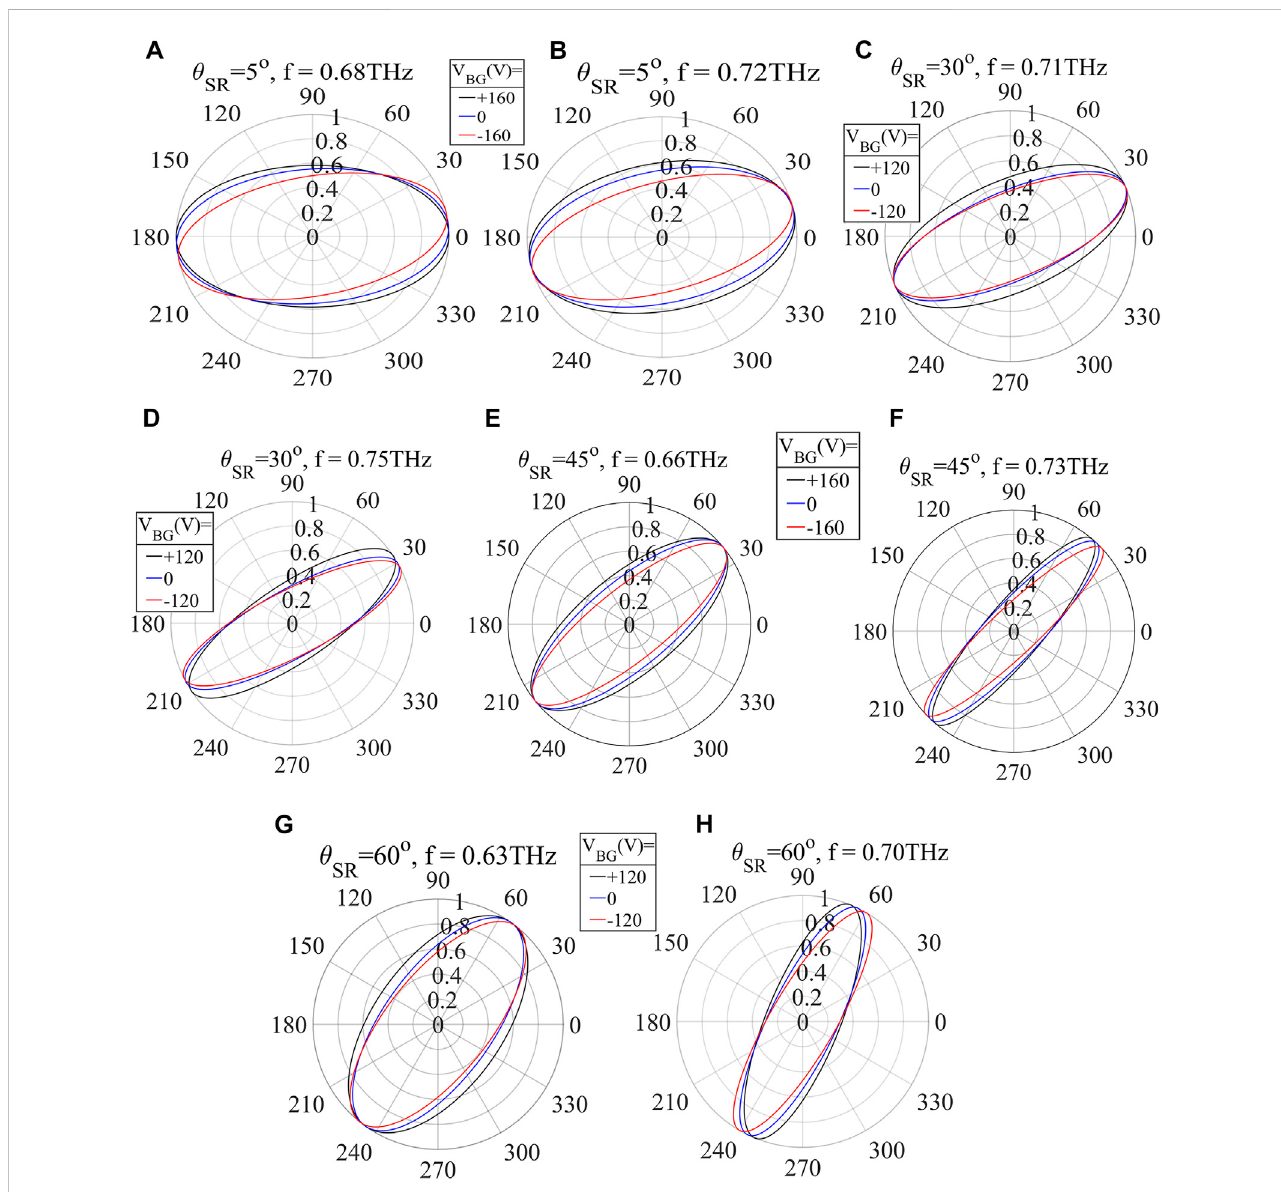
FIGURE 8 (A – H) Polarization state ellipses for different SRs angles considering the fi rst transmitted temporal pulse.